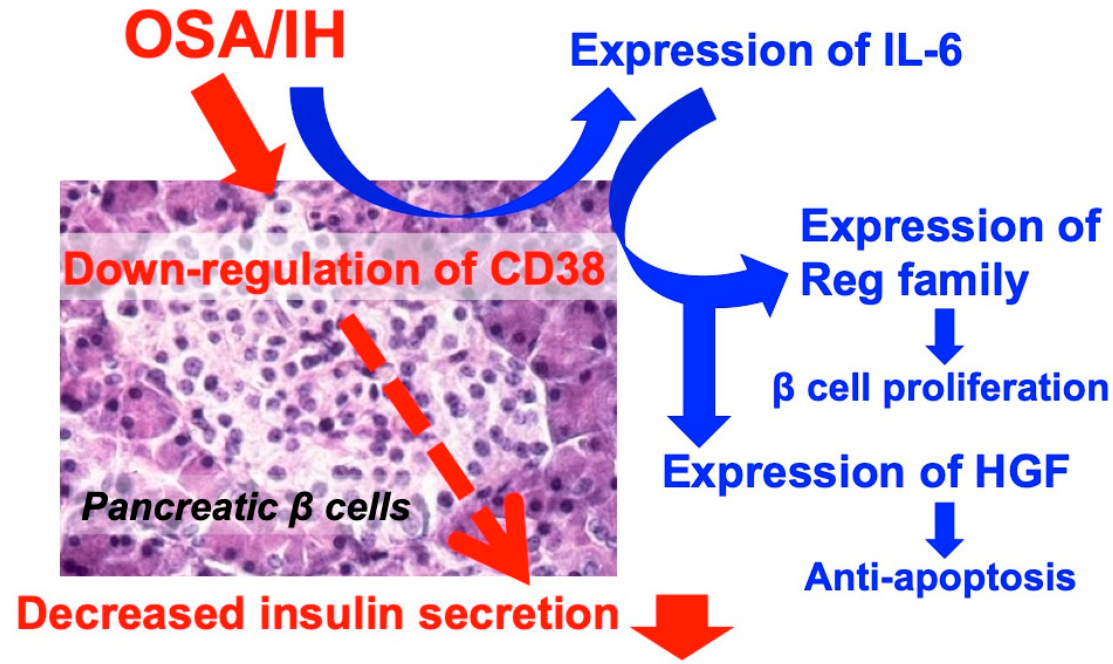
Figure 3. Possible effects of intermittent hypoxia (IH) on glucose-induced insulin secretion and β cell proliferation. IH causes the downregulation of CD38 to decrease glucose-induced insulin secretion, as well as the upregulation of IL-6. IL-6 increases the expression of Reg family genes and HGF gene Reg family members function as growth factors for pancreatic β cells and HGF works as an antiapoptotic factor. As a result, pancreatic β cells with decreased glucose-induced insulin secretion are increased.